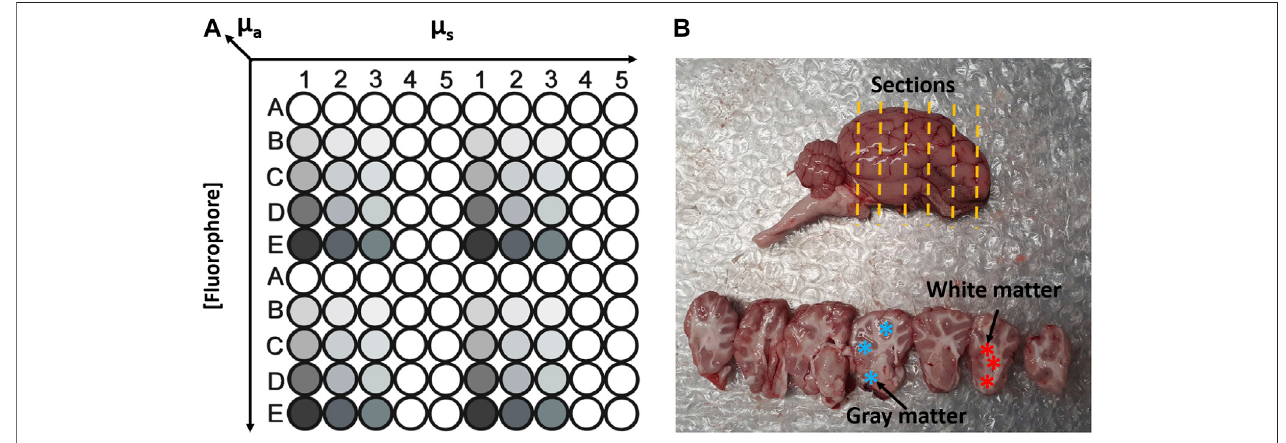
FIGURE 2 | (A) Schematic sketch to illustrate phantom matrix layout in a customised multi-well plate. (B) Photograph of sheep brain (top) and brain sectiones (bottom) . The yellow lines indicate the orientation of cut sections. Blue asterisk represent the areas of gray matter. Red asterisk represent white matter areas.